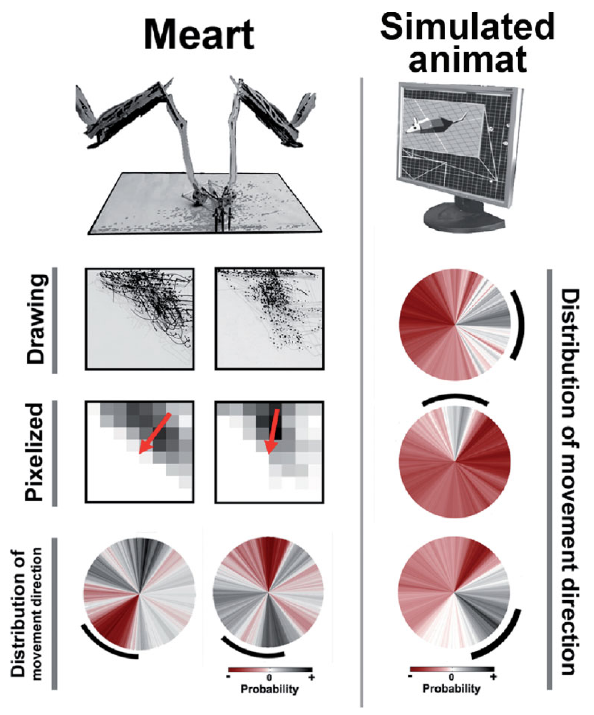
Figure 7. Plastic changes in MEART and animat behavior . Unsuccessful andsuccessfultrainingofgoal-directedanimatbehavior. MEART .Trainingwith predetermined PTS caused a shift in the probability distribution of commanded movement directions in two experiments (circles, bottom row), but in an uncontrolled manner. Marks first accumulated on a side of the drawing’s workspace (CCD camera image of the drawing and pixelized feedback), but successful PTS training should shift the markings back toward the center (red arrow middle row; black arc bottom row). The probability distribution of movement directions during 10minutes at the start of 2hour experiments was subtracted from that during the final 10minutes, thus allowing negative values(red). Simulatedanimat .Iterativelyupdatingtheprobabilityofselecting agivenPTSfortrainingallowedananimattolearntomoveinmultipledirections (circles; see Methods: Making the Semi-Living Artist). Desired angles of 0, 90, and − 45 degrees (black arcs) were applied in consecutive 2hour periods. Successful behavior was considered to be movement within the desired angle ± 30 degree. Notice the changes in probability distribution of